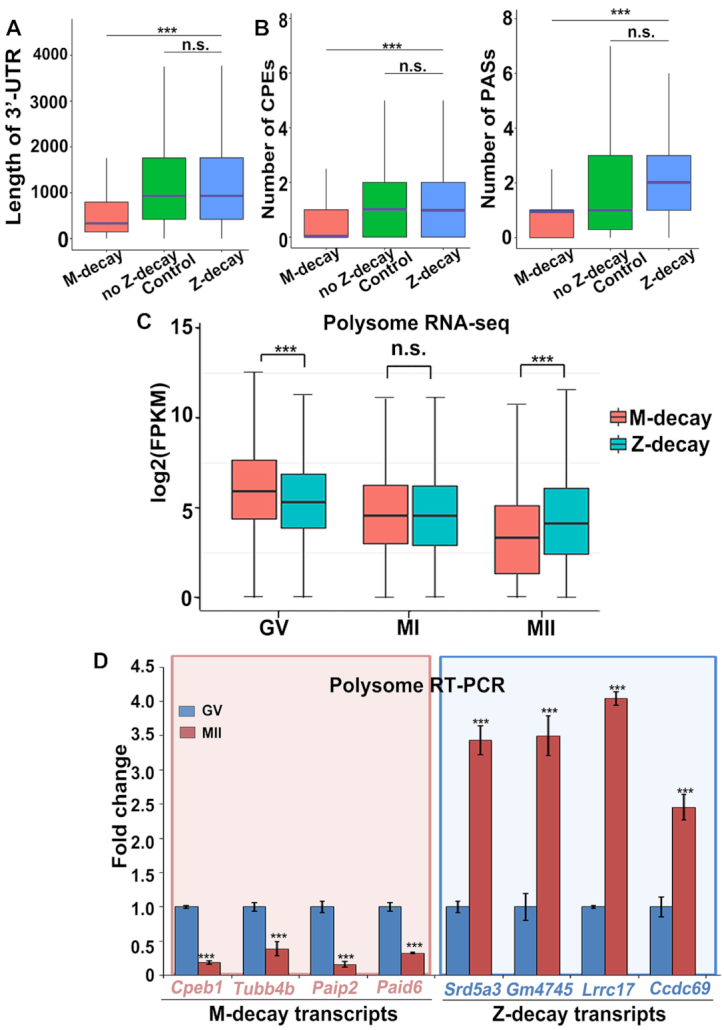
Influence of 3′-UTR length and translational activity on the timing of mRNA degradation. (A and B) Average 3′-UTR length (A) and numbers of CPEs and PASs (B) in the 3′-UTR of murine M-decay, Z-decay, and length-controlled non-Z decay transcripts. The box indicates upper and lower quantiles, the purple thick line in the box indicates the median.***P < 0.001 by two-tailed Student's t-test. n.s.: non-significant. (C) Levels of polysome-bound M-decay and Z-decay transcripts in oocytes at the GV, MI and MII stages (two biological repeats). The expression level of each transcript was normalized by the mCherry spike-in, which was in vitro transcribed and equally added to each sample before RNA extraction. The box indicates upper and lower quantiles, and the line in the box indicates the median. ***P < 0.001 by two-tailed Student's t-test. n.s.: non-significant. (D) RT-qPCR results showing the relative mRNA levels of M-decay and Z-decay transcripts in association with polysomes at the GV and MII stages. Error bars, s.e.m. ***P < 0.001 by two-tailed Student's t-test. n = 3 biological replicates.